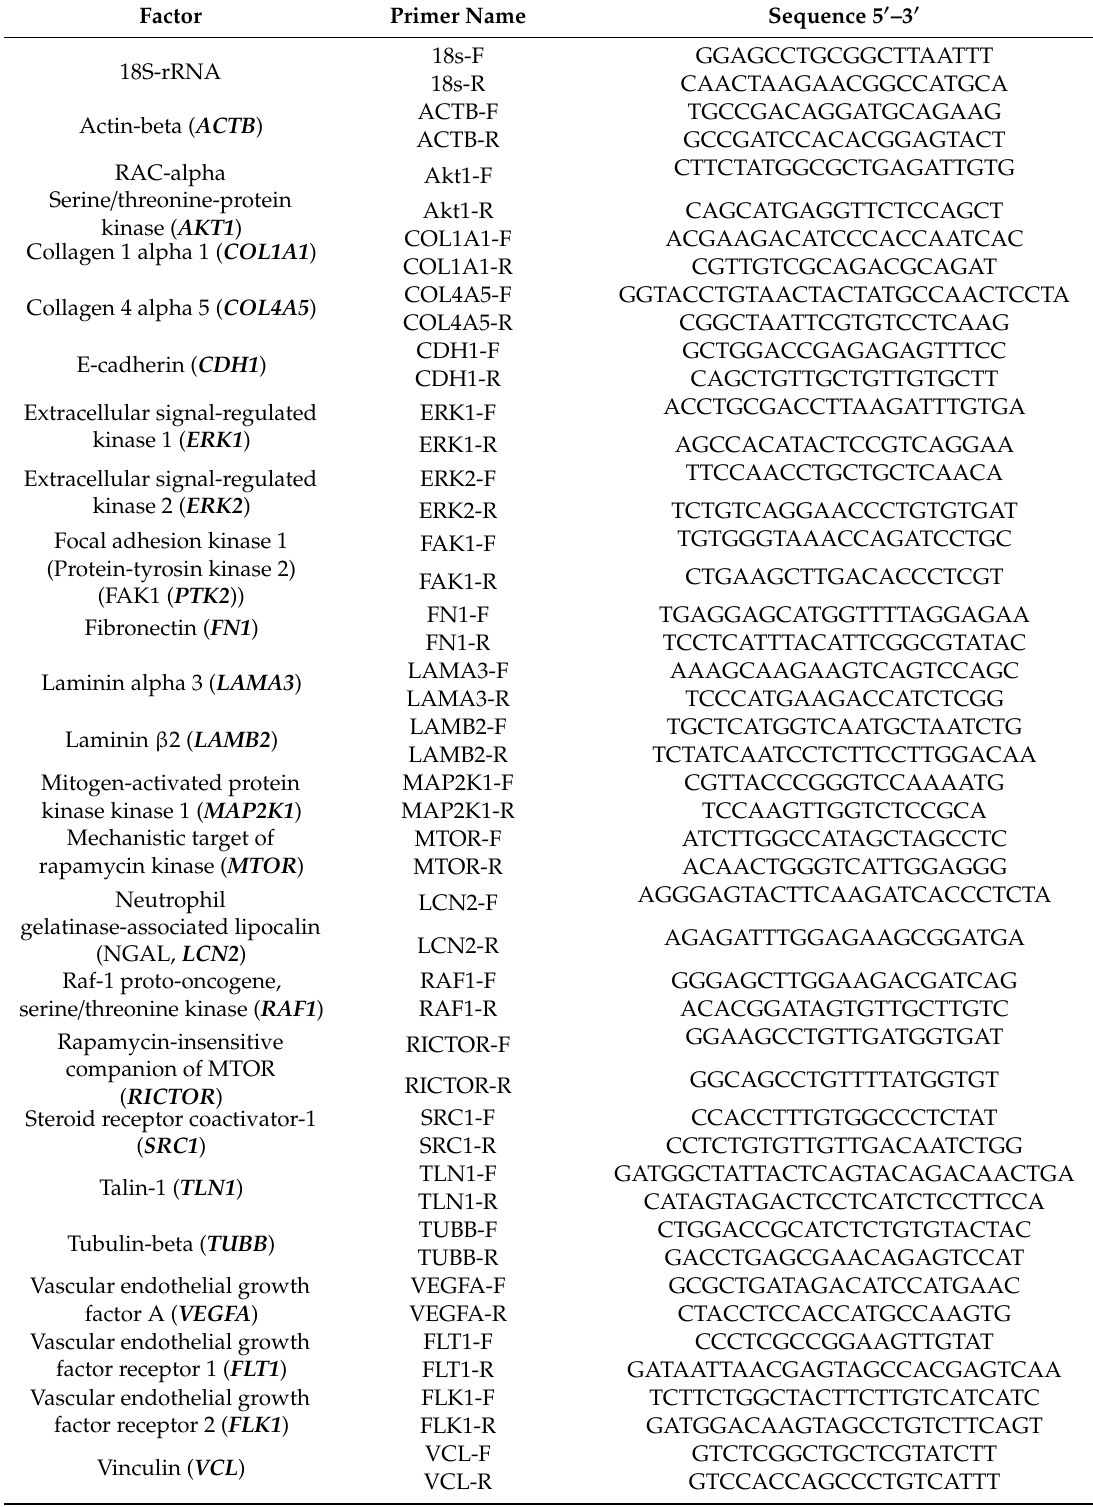
Table 1. List of primer sequences used in quantitative PCR. All sequences are listed in the 5 (cid:48) –3 (cid:48) direction. Factor Primer Name Sequence 5 (cid:48) –3